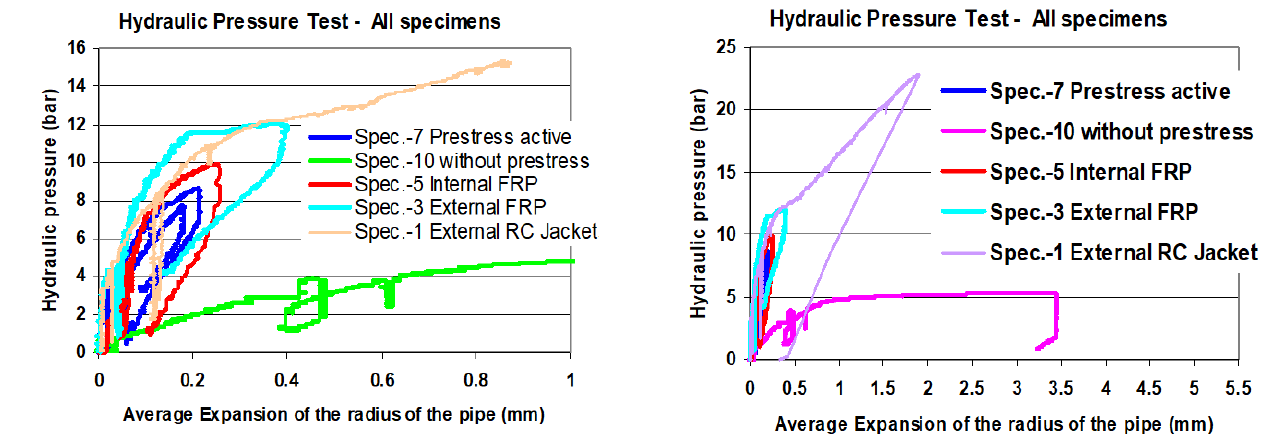
Figure 19. Radial expansion versus internal hydraulic pressure response for all tested specimens.